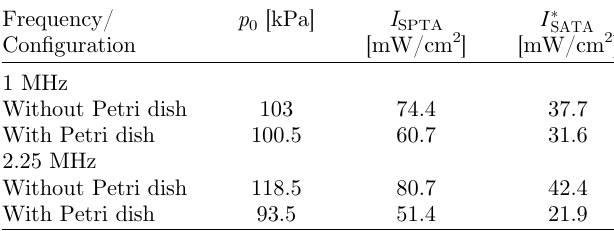
Figure 7. Ultrasound temporal-average intensity distribution I TA [mW/cm 2 ] without (left – Fig. 3a) and with (right – Fig. 3b) the Petri dish for 2.25 MHz-transducer at z f = 39 mm. The white circle represents the area of the transducer. Table 2. Measured peak acoustic pressure and